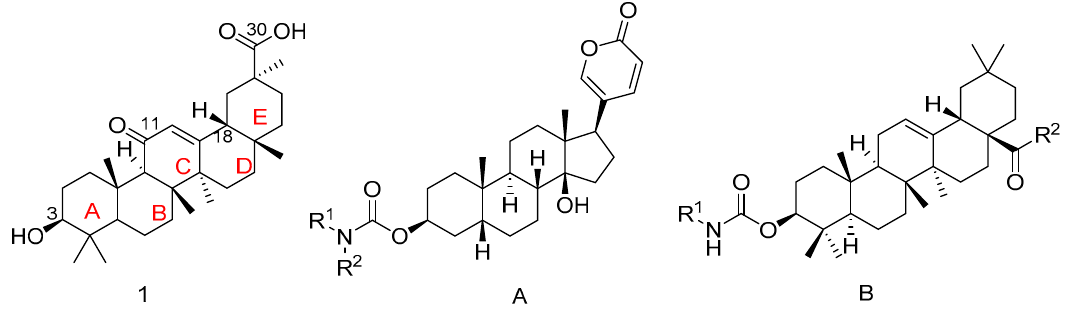
Figure 1. Structure of 18 β -GA 1 and known derivatives A and B .